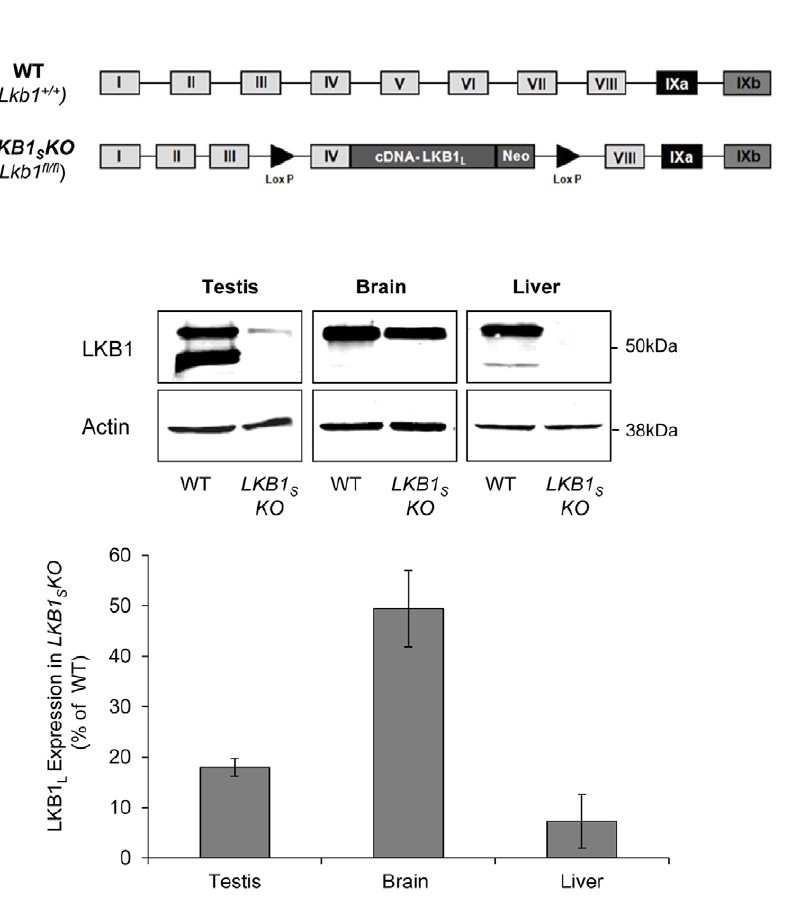
Figure 1. LKB1 expression in LKB1 S KO mice. A ) Generation of LKB1 S KO mice, adapted from [19]. Exons IV–VII (encoding the kinase domain) of the wild-type (WT) Lkb1 gene were replaced by a cassette encompassing exon IV plus cDNA encoding the rest of LKB1 L . This cassette was flanked by lox-P excision sites ( c ) and contained a neomycin (Neo) gene for selection. Mice homozygous for expression of this cassette ( Lkb1 fl/fl ) no longer express LKB1 S and are de facto LKB1 S KO mice. B ) Mouse tissues homogenates were analysed by western blotting with a monoclonal antibody raised against total LKB1. An anti-actin antibody was used to show equal loading. Representative blots are shown and the migration of molecular mass standards are as indicated. C ) Quantification of the relative intensity of the LKB1 L band between wild-type and LKB1 S KO mice is shown in the bar graph below. Results are plotted as the percentage expression of LKB1 L in LKB1 S KO mice compared to wild-type and are the means 6 S.E.M. of three separate blots from three individual mice.